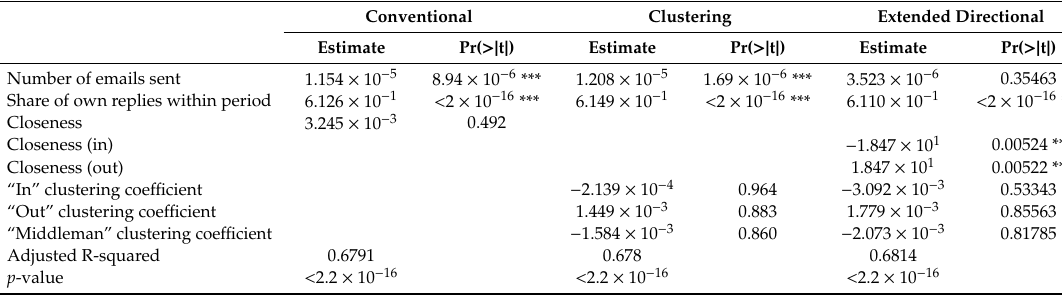
Table A4. Enron dataset, 1-day